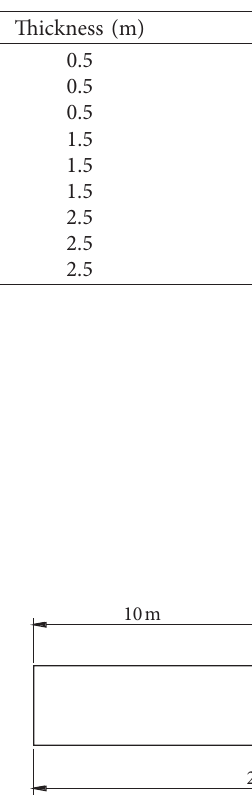
Table 1: Orthogonal experiment scheme of weak interlayer’s influence on bench blasting effect.